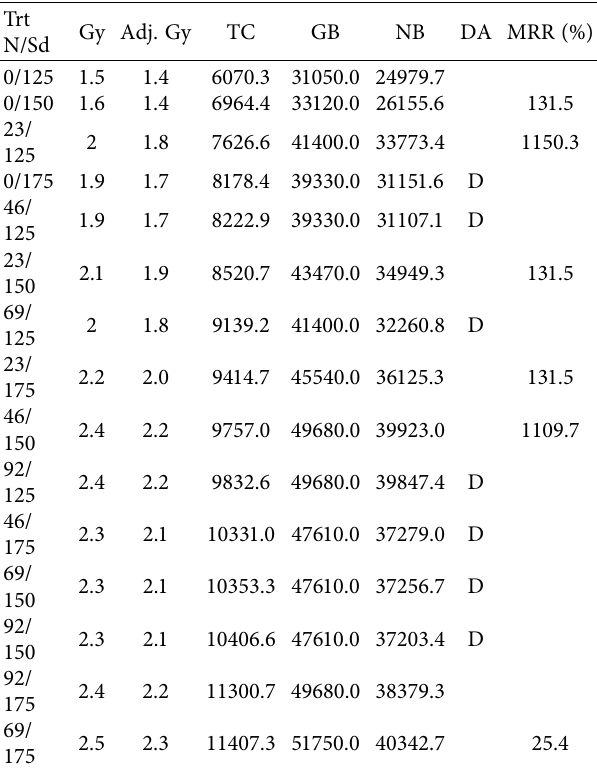
Table 10: Te efects of N fertilizer application and seed rate on the economic proftability of bread wheat production at Degem district during 2020 under irrigation